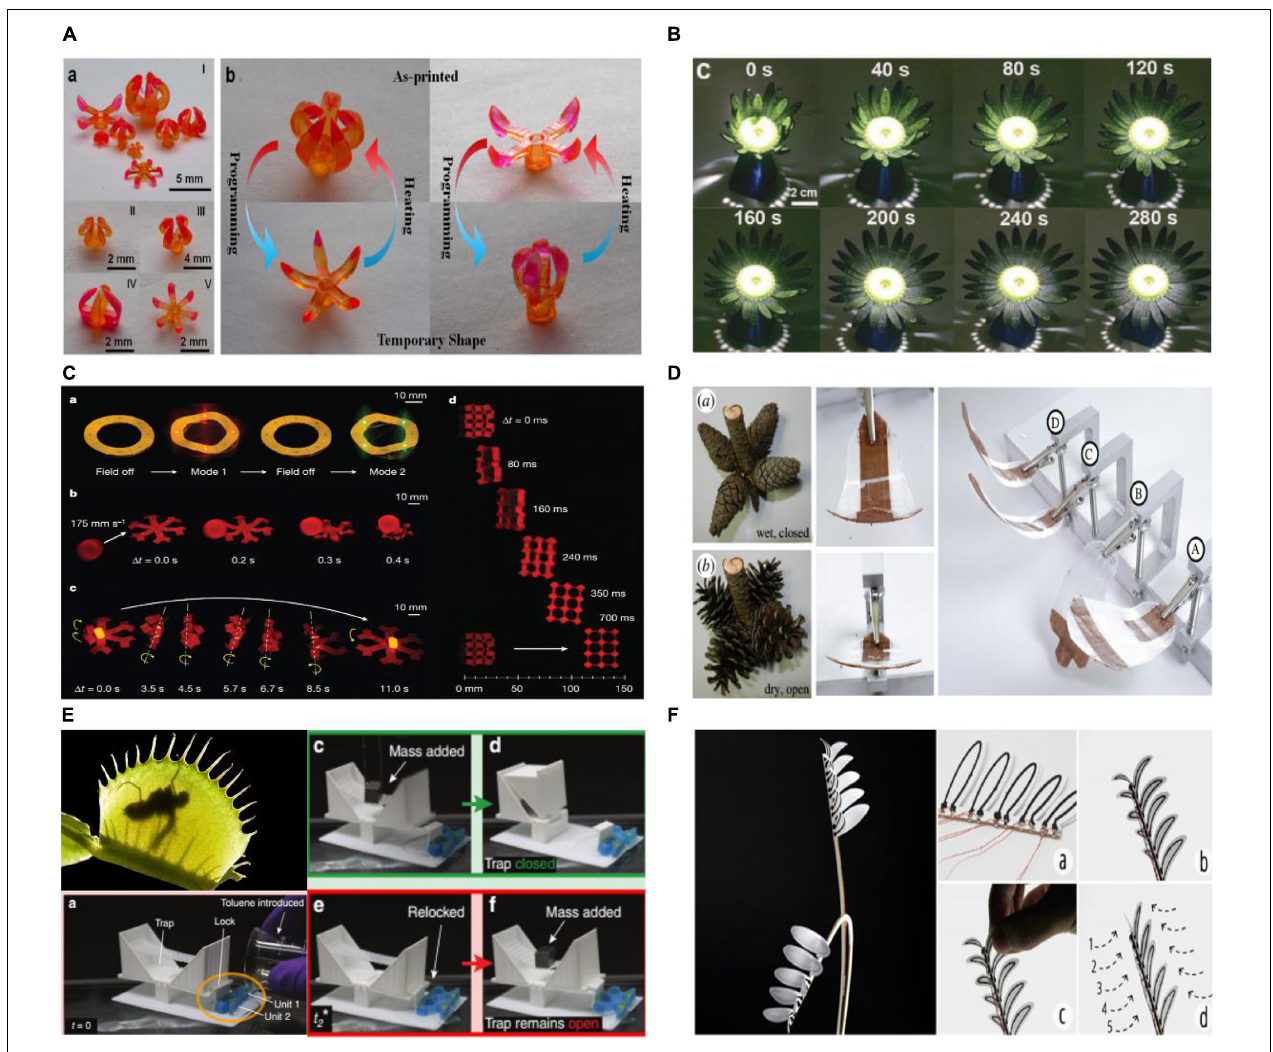
FIGURE 4 | The soft actuators by mimicking the locomotion of plants in nature. (A) Sequential recovery of a multimaterial shape memory actuator mimicking the opening and closing of flowers when triggered by heat. (B) Blooming of the photoresponsive shape memory composites mimicking the opening of flowers when triggered by light. (C) Movements of magnetic responsive soft actuators using programmed magnetic field. (D) Bending of the hygroscopic wood polymer composites mimicking the curvature deformation of pine cones. (E) Fast closing of two bistable units with embodied logic mimicking the trapping process of the Venus flytrap. (F) Sequential actuation of shape memory composites via current-driven Joule heating mimicking the sensing and actuation behaviors of mimosa